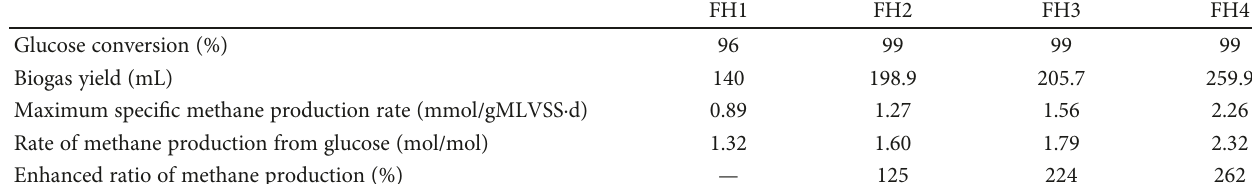
Table 1: Biogas yields and methane production performance of FH1 to FH4.